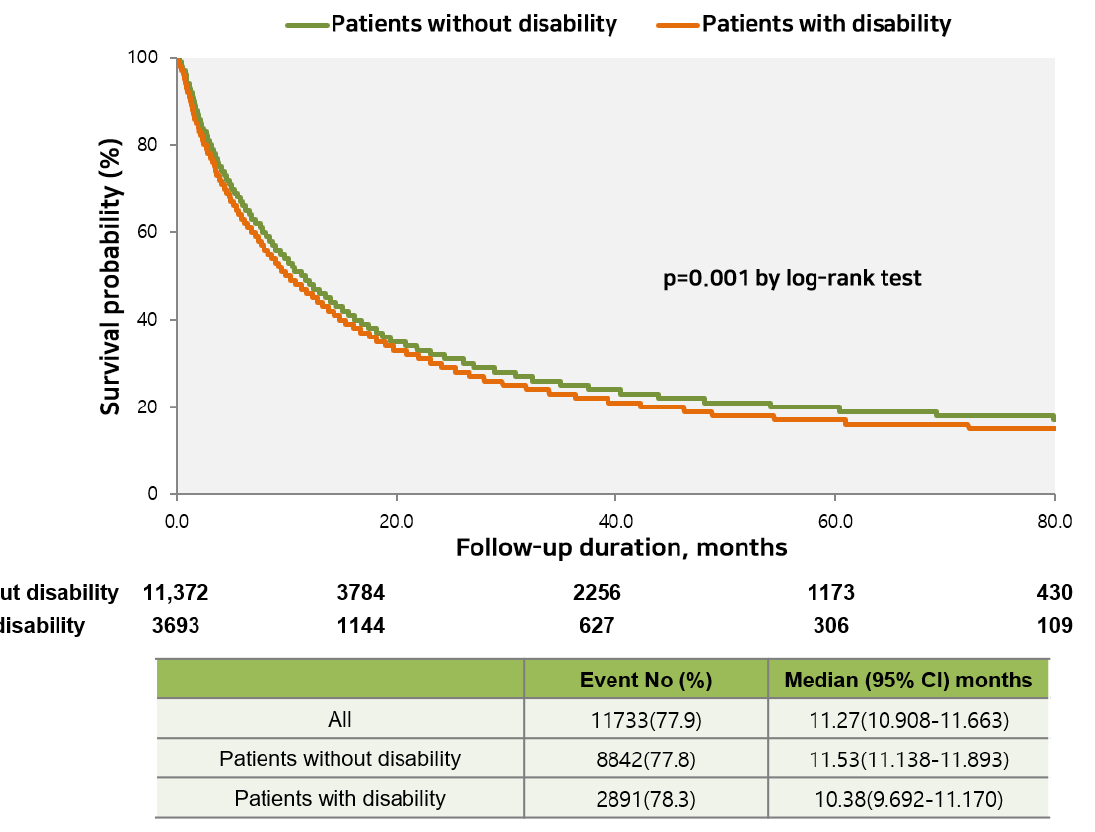
Figure 3. Comparison of cancer-specific survival between patients with and without disabilities. Among the various disability types, patients with severe brain (aHR = 1.65, 95% CI: 1.29–2.12) or mental disabilities (aHR = 1.65, 95% CI: 1.29–2.12) exhibited poorer BDC- specific mortality. When overall and BDC-specific mortality was analyzed separately in men and women, the overall hazard ratio was slightly higher in men than in women with disabilities (Tables 6 and 7 and Supplementary Tables S3-2 and S3-3). However, mortality was higher in women with mental disabilities compared to their male counterparts .